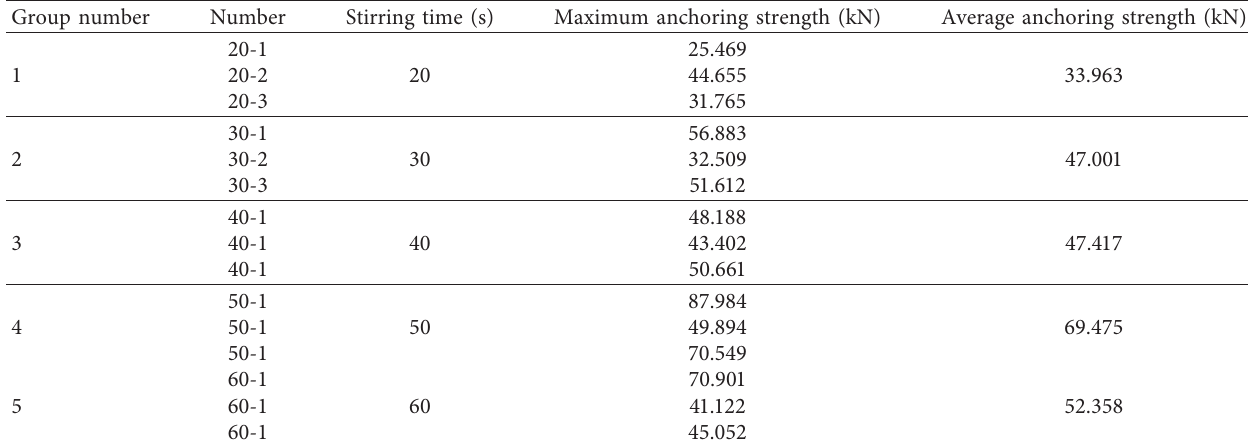
Figure 20: Average anchor stress-stirring time Table 5: Anchor force at different stirring time.